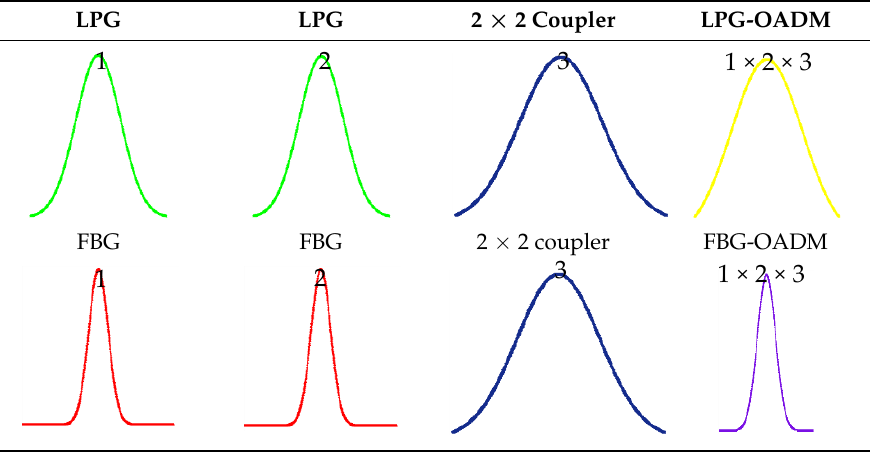
Table 1. Comparison of spectrums between the LPG-OADM and FBG-OADM.